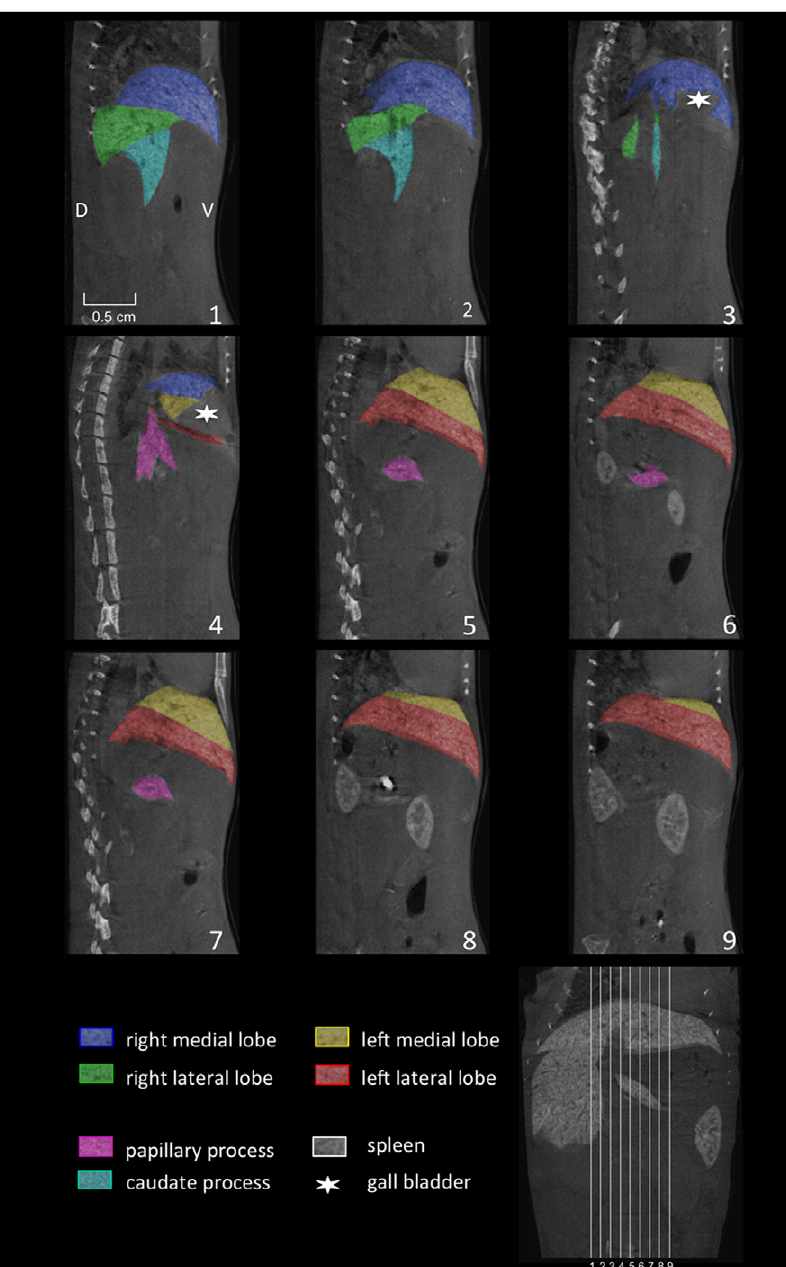
Figure 3. Saggital reconstructed micro-CT images. Micro-CT of the liver of a C57BL/6J mouse was performed 3 hours after injection of 100 m l of a nanoparticular contrast agent (ExiTron nano 12000). The color-coding of the single liver lobes corrsponds to the color coding presented in Figure 1. The slice orientation in relation to a coronal section is shown in the lower right corner.